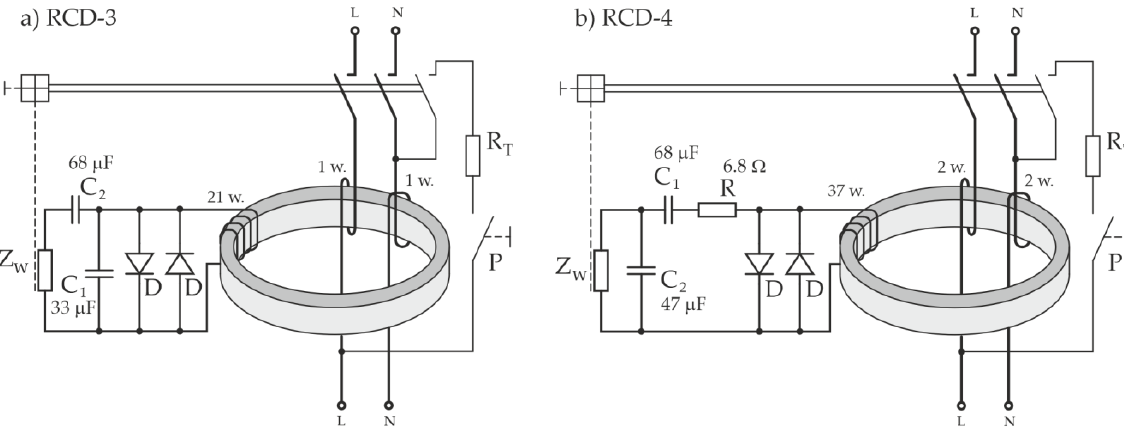
Figure 8. Diagram of the internal structure of the tested circuit breakers: ( a ) RCD-3 and ( b ) RCD-4.